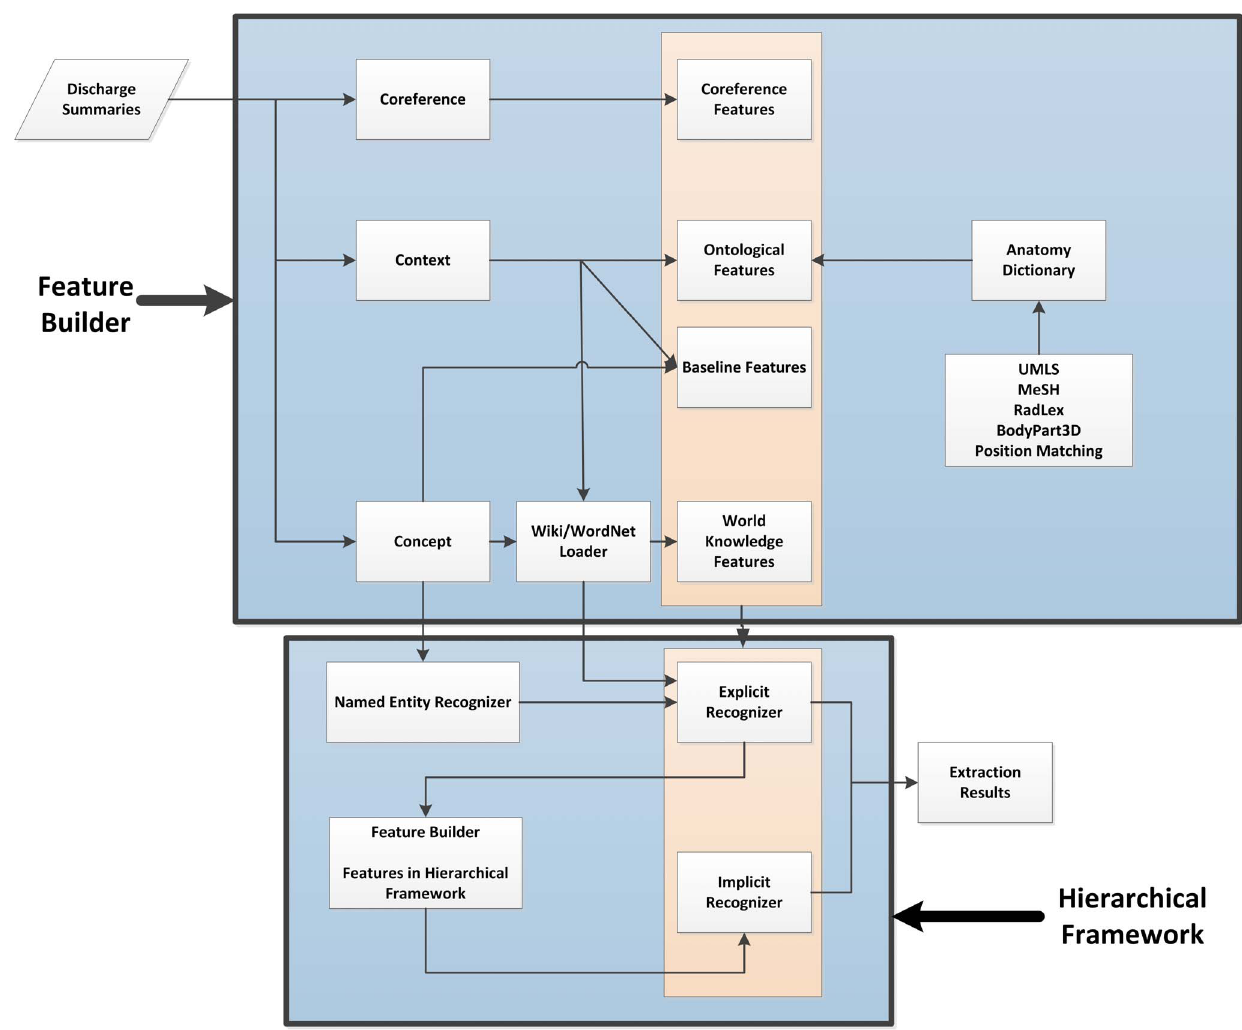
Figure 1. Overview of system workflow.